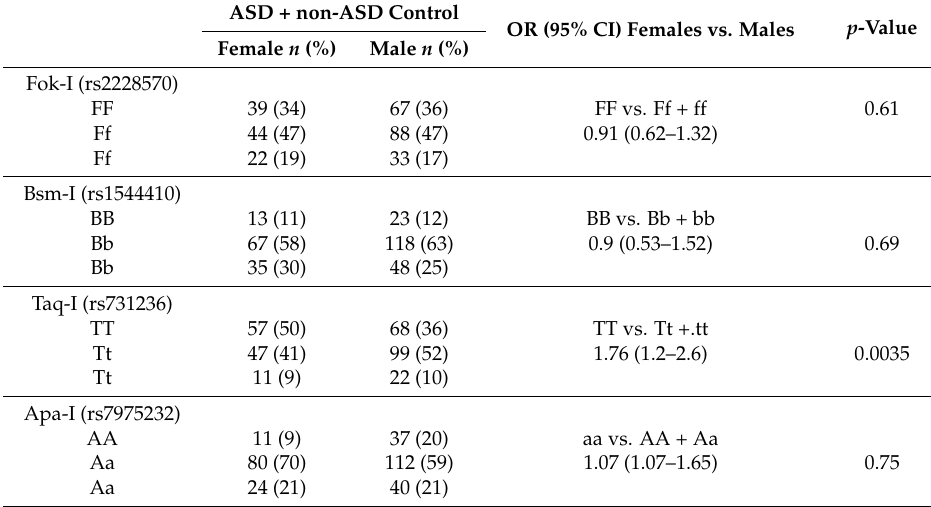
Table 3. Genotype frequencies of VDR SNPs and associations with